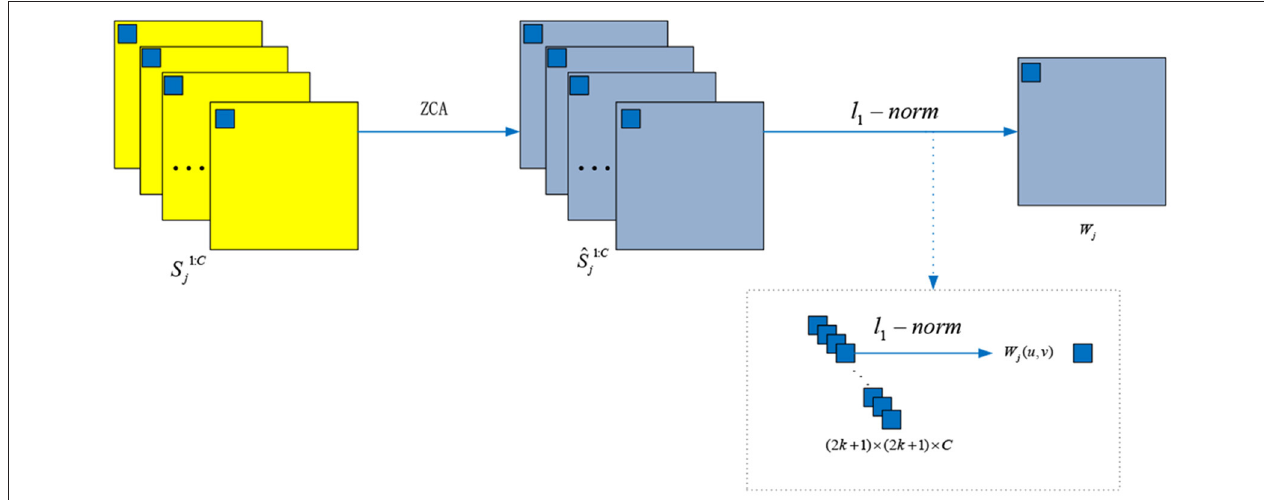
FIGURE 4 | The ZCA and l 1 -norm operations for whiting the score maps and generating the weight maps,